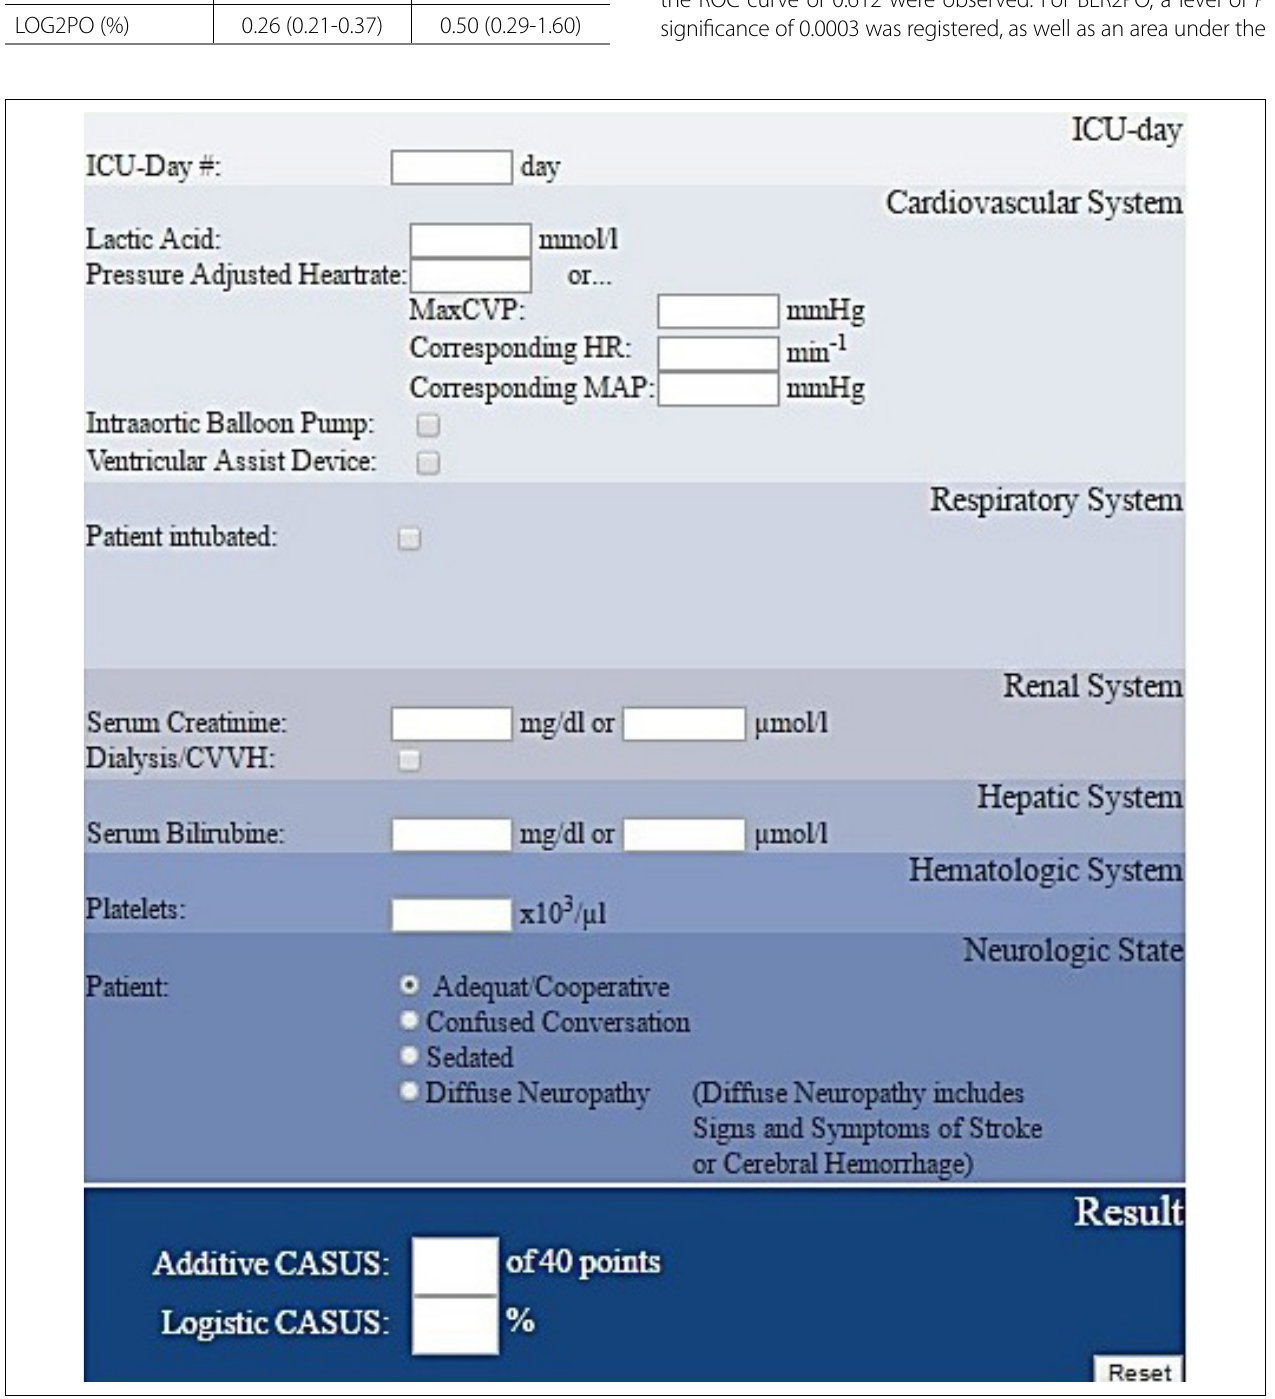
Fig. 1 - CASUS Online Calculations (http://www.cardiac-icu.org/Online-Calculation.html) [5]